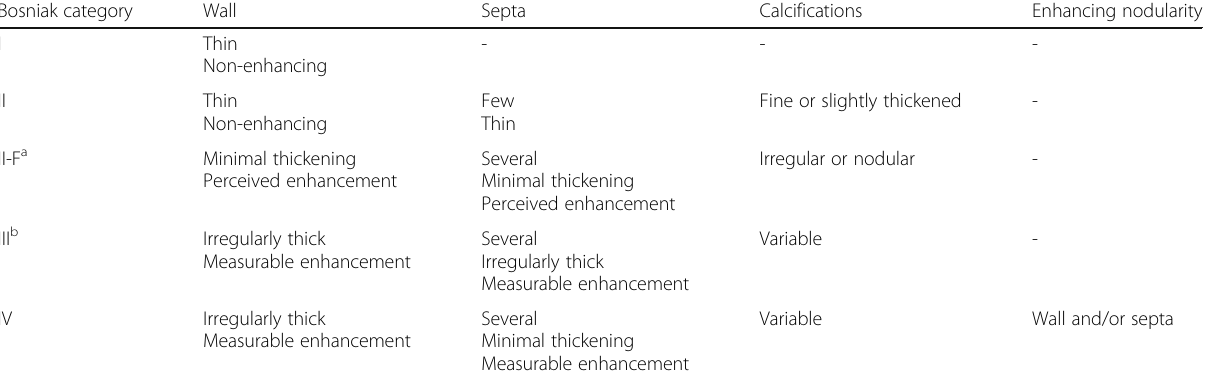
Table 1 The five categories of renal cysts, divided on the basis of imaging appearance Bosniak category